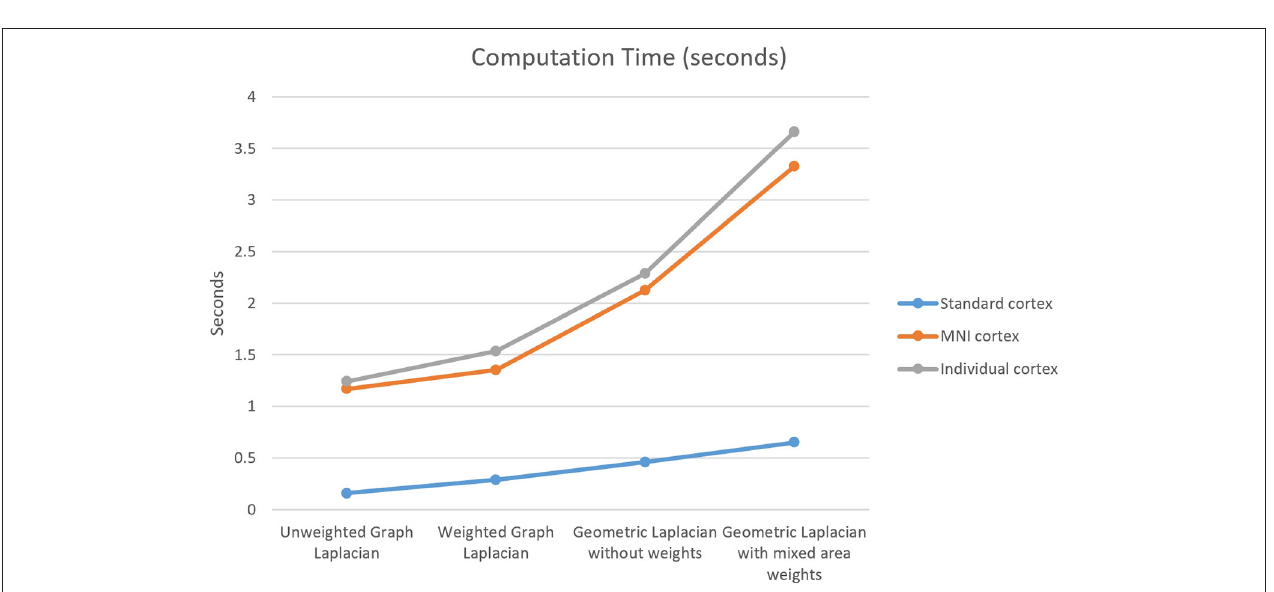
FIGURE 10 | Computation time for the four Laplace operators and three different cortical meshes. The standard cortex contained 750 nodes, the MNI cortex contained 3,709 nodes, and the individual cortex contained 3,973